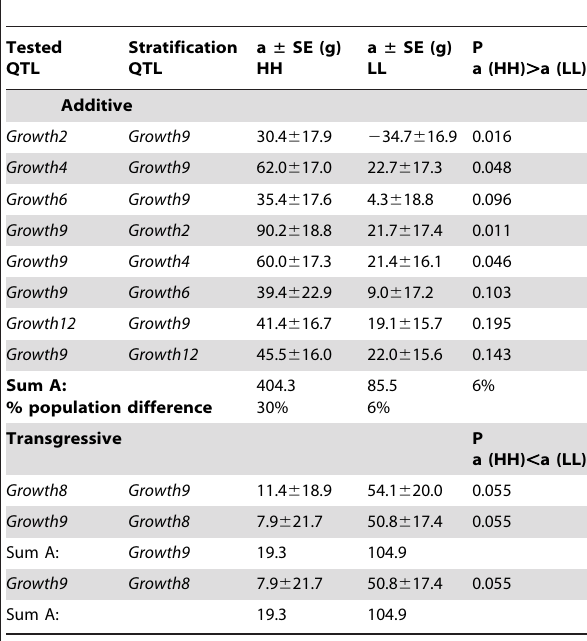
Table 2. Genetic effects of five epistatic QTLs for body weight in the Viriginia AIL in alternate genetic backgrounds.